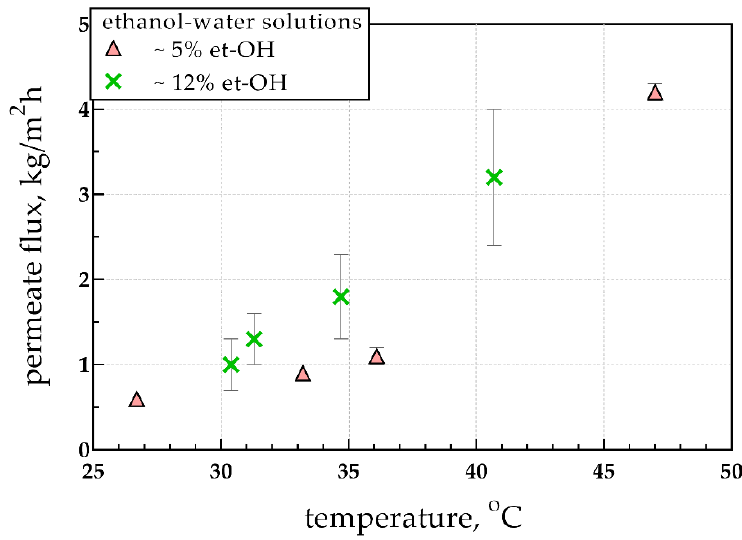
Figure 6. Permeate flux versus the feed solution temperature for ethanol-water mixtures distillation.